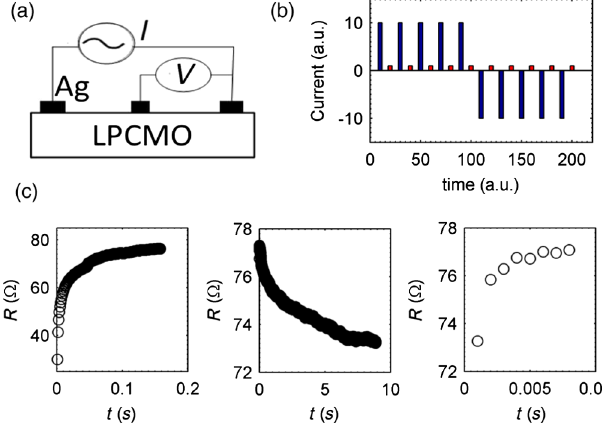
FIG. 7. Evolution of the resistance during the switching phase for different applied currents according to simulations (dots) and theory (lines) from Eq. (6). The currents shown are I ¼ 58 . 5 a : u : , 71.5 a.u., 84.5 a.u. and 97.5 a.u.